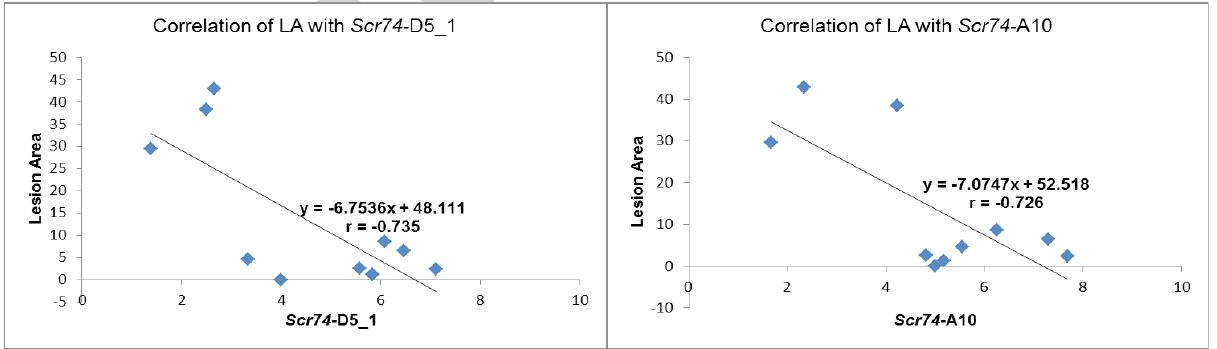
Figure 7. Scatter plot on the correlation between cell death to two Scr74 variants ( Scr74 -A10 & Scr74 -D5_1) and lesion area from katshaar isolate, LA = lesion area, r = Pearson correlation coefficient, a straight line depicts a linear trend in the data as the equation given y=